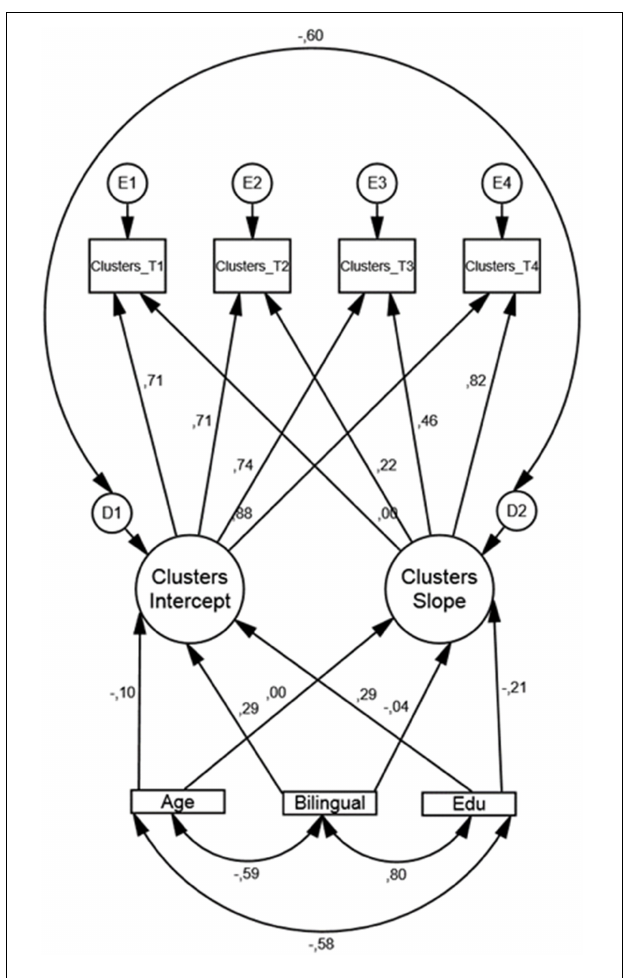
FIGURE 3 | Conditional LGM for number of clusters with bilingualism, age, and education as covariates along with standardized regression weights. Edu = years of formal schooling, Bilingual = (coded as 1 = yes and 0 =